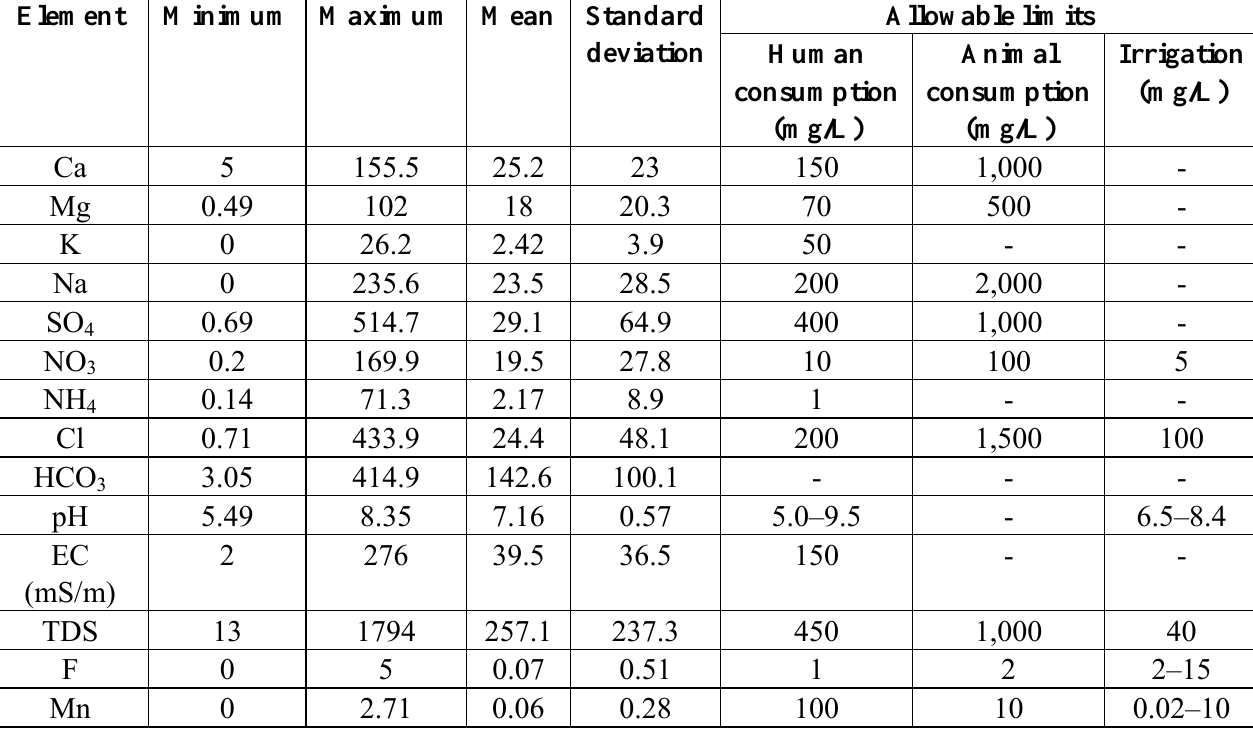
Table 1. Summary of the water quality and comparison with standards.